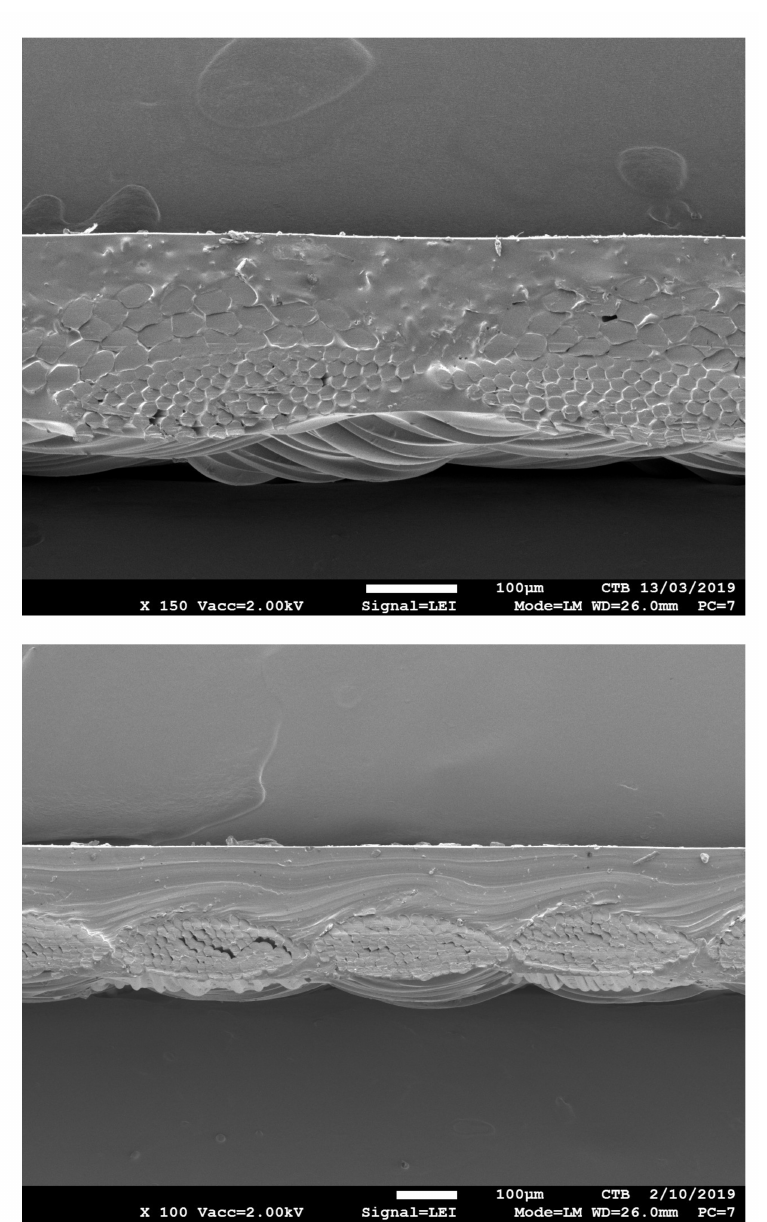
Figure 4. SEM pictures of bio-based 2K PU coating on the polyester fabric ( below ) and bio-based 2K PU coating on the pre-treated polyester fabric ( above